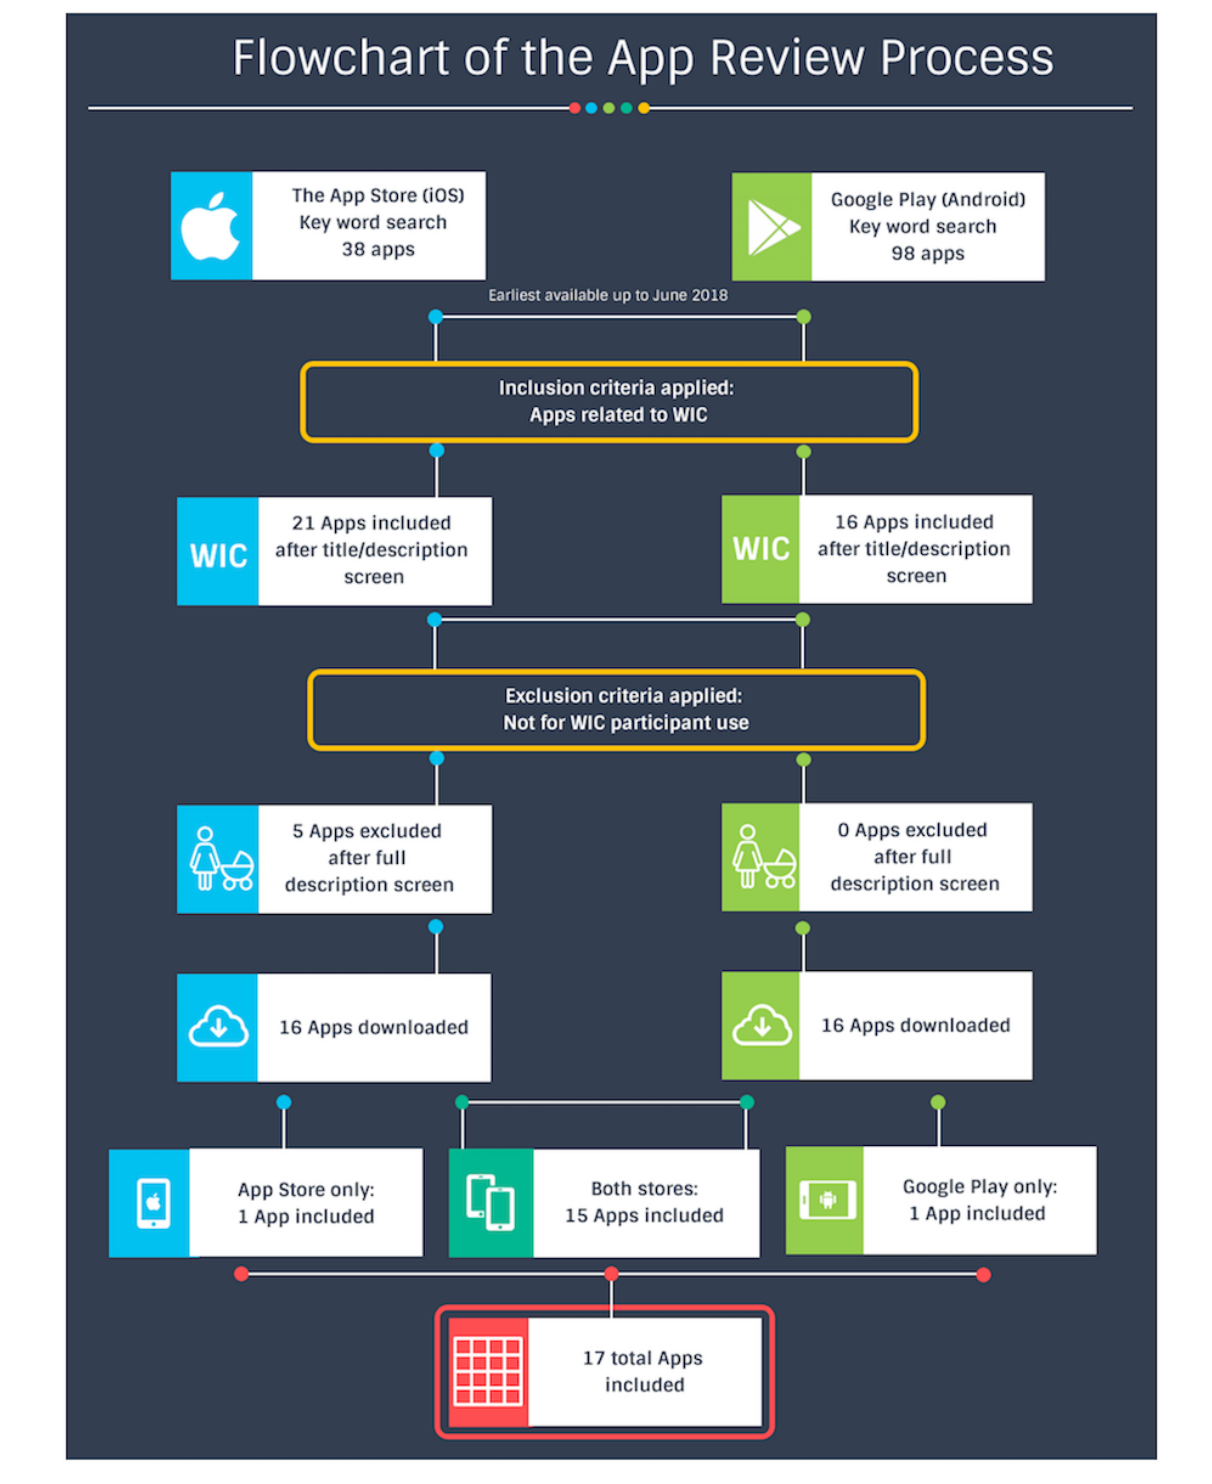
Figure 1. Flowchart of the app review